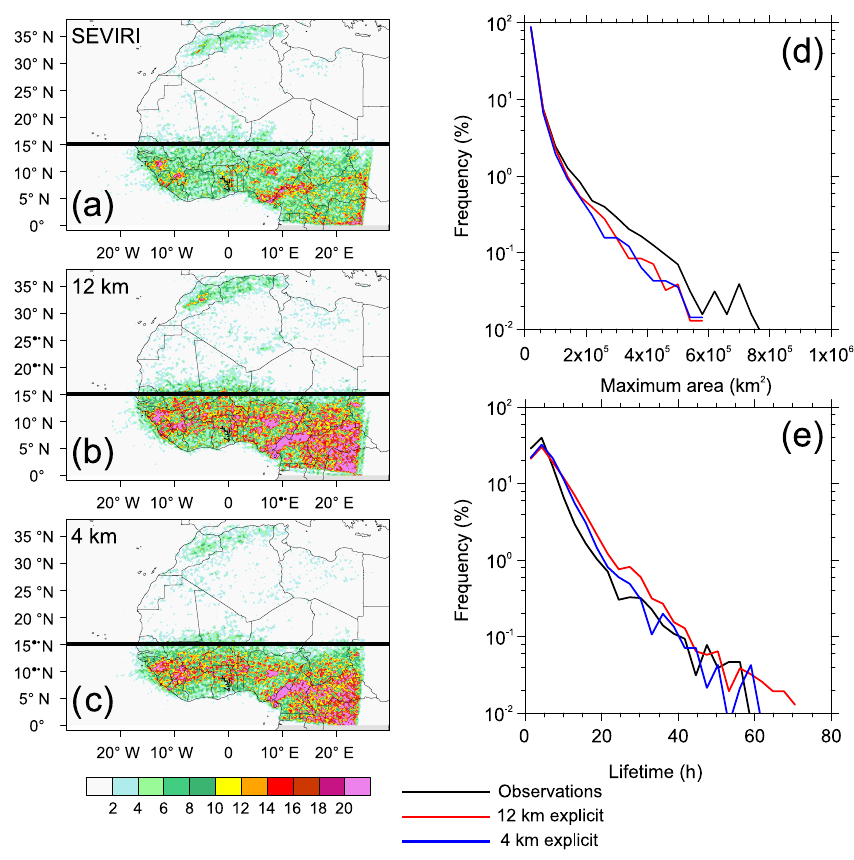
Figure 11. Storm-tracking mesoscale convective system (MCS) track density for (a) observed MCSs, (b) MCSs in the 12km convection permitting simulation and (c) MCSs in the 4km convection-permitting simulation. Area and lifetime distributions for the tracked MCSs are also shown in (d, e) . 15 ◦ N is highlighted on the track density plots (a–c) to aid in the interpretation between tracks obtained from observations and those from simulations in the marginal region where the amount of dust is known to be raised in reality but is not raised in the